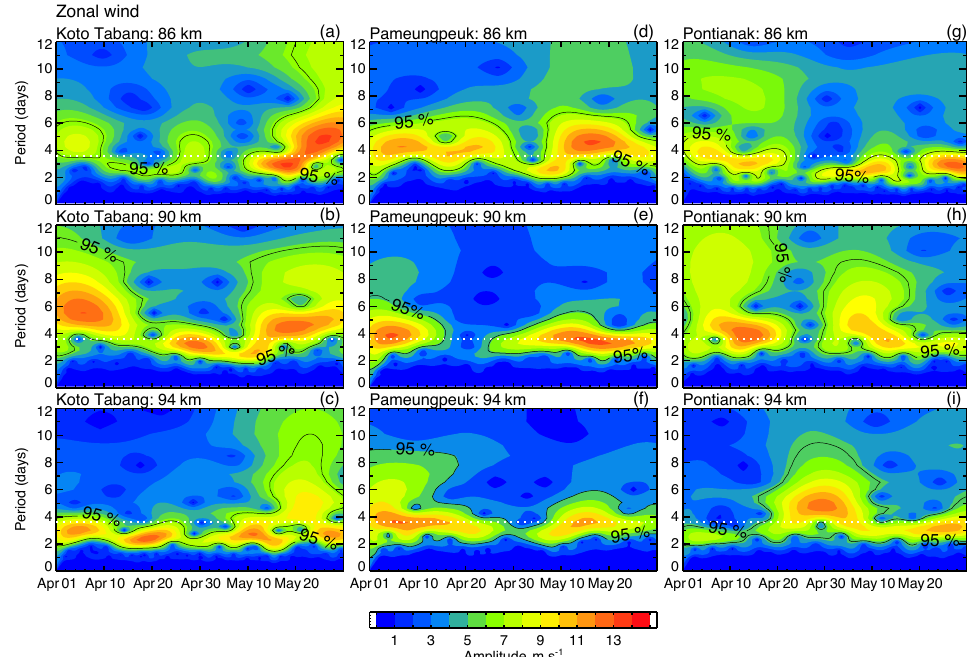
Figure 9. Contours of wavelet intensities as a function of frequency and time for the zonal wind of IMF3 at three different heights (86, 90, and 94km) over Kototabang, Pameungpeuk, and Pontianak locations.